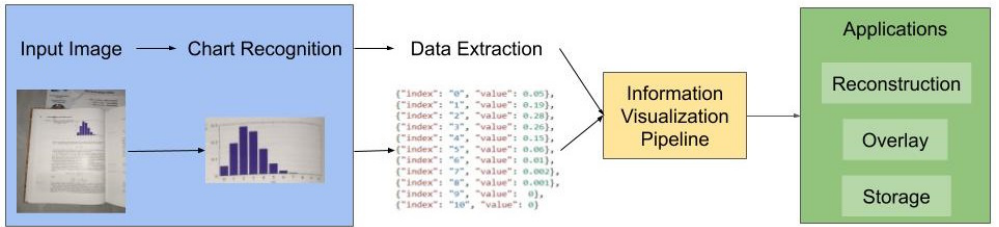
Figure 2. Automatic main process of chart recognition, from the input image to applications. The main process can transform a static environment in a rich user interface for manipulation of data. The information visualization pipeline is environment free, allowing the applications to be used in many environments. This is only possible when the initial step cleans the chart and gives information (blue area).